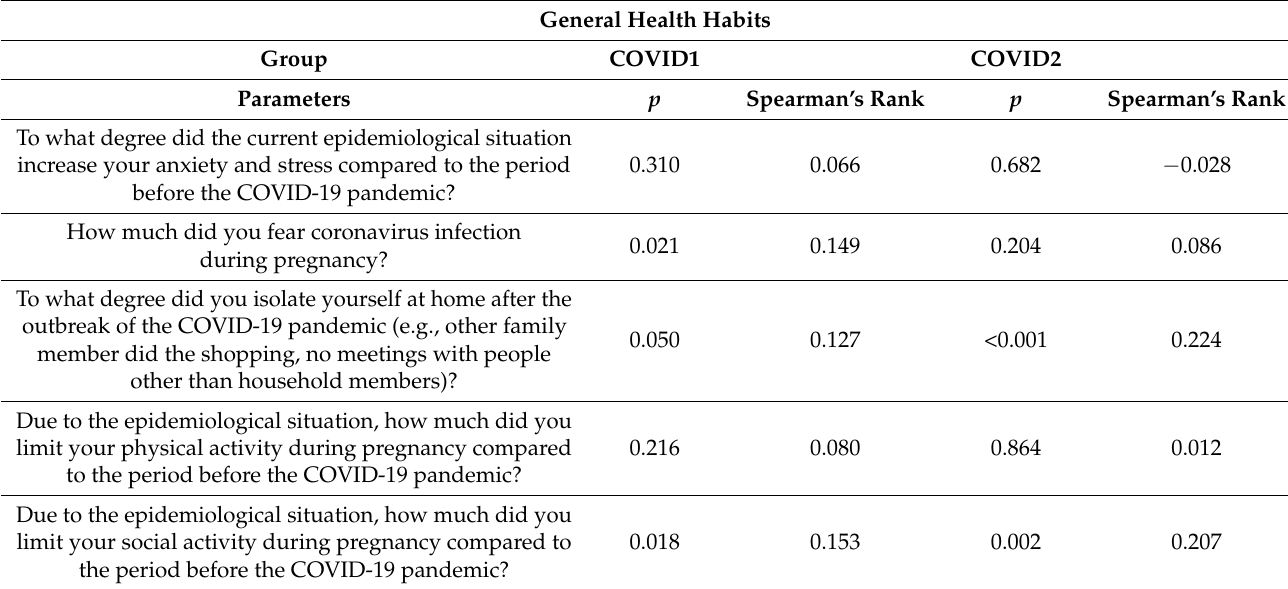
Table A6. Changes in lifestyle and psychophysical status and the level of general health habits in women giving birth during the